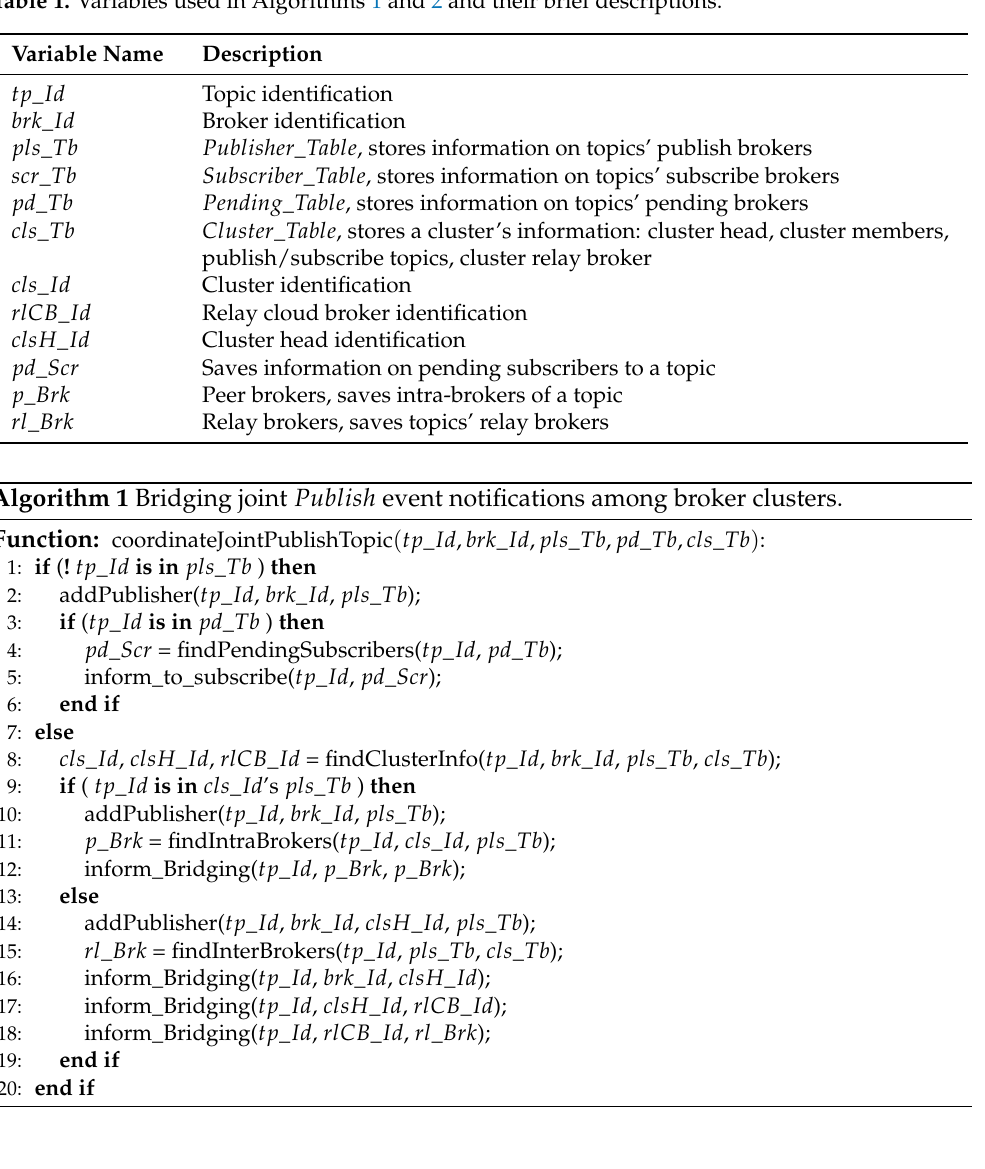
Table 1. Variables used in Algorithms 1 and 2 and their brief descriptions.